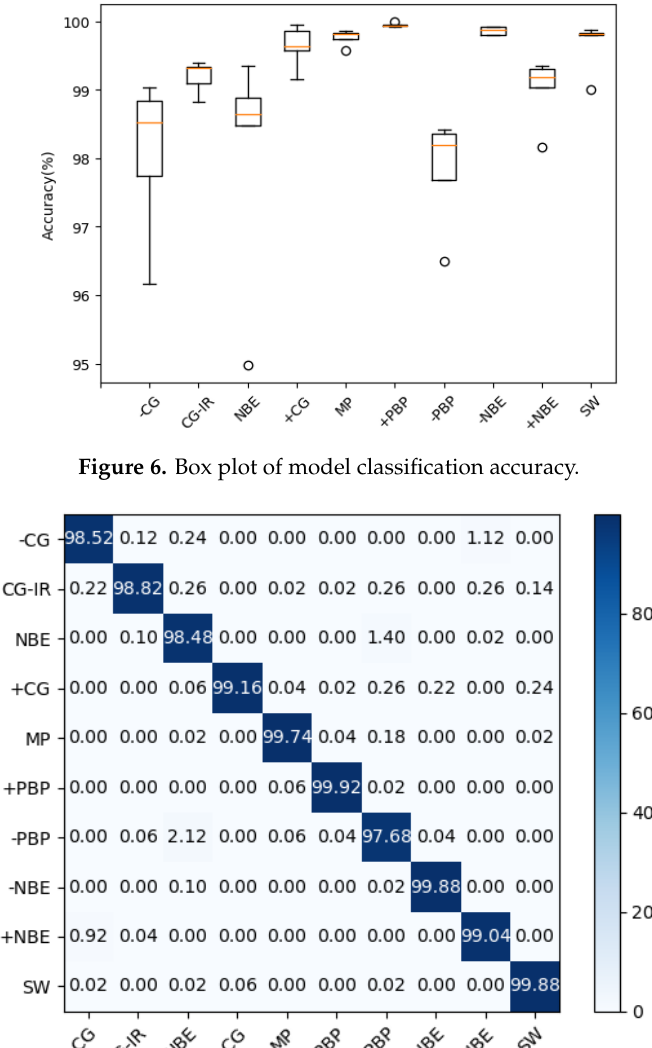
Figure 8. Thunderstorm map. The red pentagram represents a site location. The model classification results are shown in Table 3. Through manual inspection, the model ’ s recognition accuracy of various signals was given. The overall classification accuracy of the model was 97.55%. For most categories, the classification accuracy was above 97%.